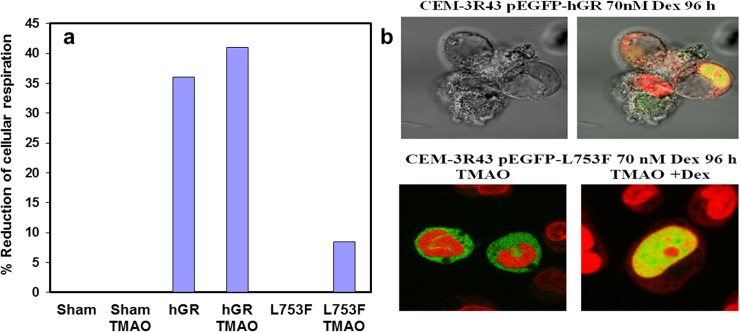
Effects of TMAO on GC-driven GR nuclear translocation and loss of cell viability.(A) Loss of cell viability, estimated by water-soluble tetrazolium mitochondrial respiration assay. To maximize effect, cells were treated with 10-6M Dex ±TMAO. “Sham” = electroporation without plasmid; “GR” = wild-type hGR; “L753F” = GRact/l. In this experiment, p < 0.05 (paired t-test) only for TMAO vs TMAO + Dex in GRact/l (L753F) transfected cells (n = 3). (B) Confocal microscopy showing transfected EGFP-GR in nuclei of 3R43 cells after 70nM (to enhance assay sensitivity) Dex treatment. Upper Panel left, clump of cells without, and right, same cells with fluorescence; Lower Panel, cells transfected with EGFP GRact/l. Left, 2 cells in TMAO-supplemented medium, showing cytosolic GR. Right, in TMAO medium plus Dex, a cell showing nuclear GR. Green fluorescence, EGFP fusion GR; red fluorescence, nuclei stained with Draq5.